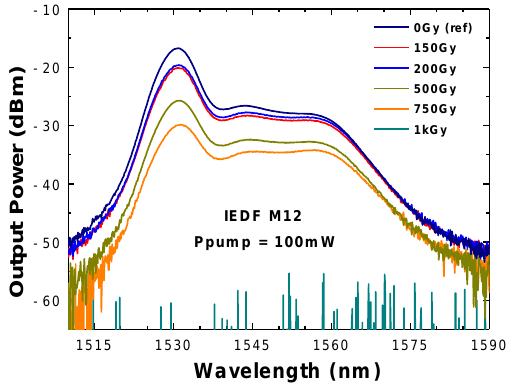
Figure 6. ASE spectra obtained from a 5 m length of EDF M12 irradiated with different doses from 0 Gy (reference) up to 1 kGy when pumped by a 976 nm light source with 100 mW.